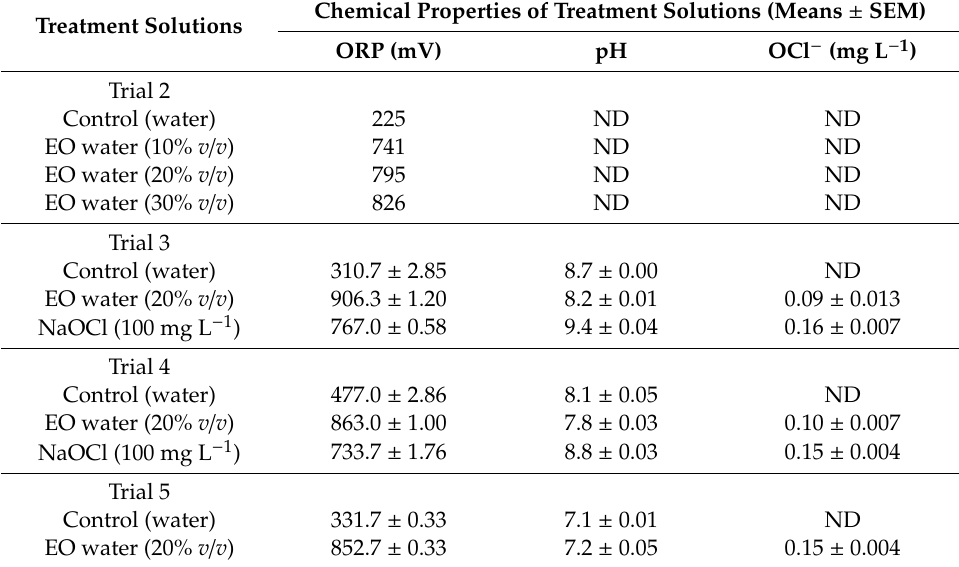
Table 9. Chemical properties of treatment solutions. Table 3. Effect of electrolyzed oxidizing (EO) water and synthetic fungicide on anthracnose lesion Treatment area and ripening properties of avocado (cv. Hass) after inoculation with Colletotrichum siamense , Trial 2.